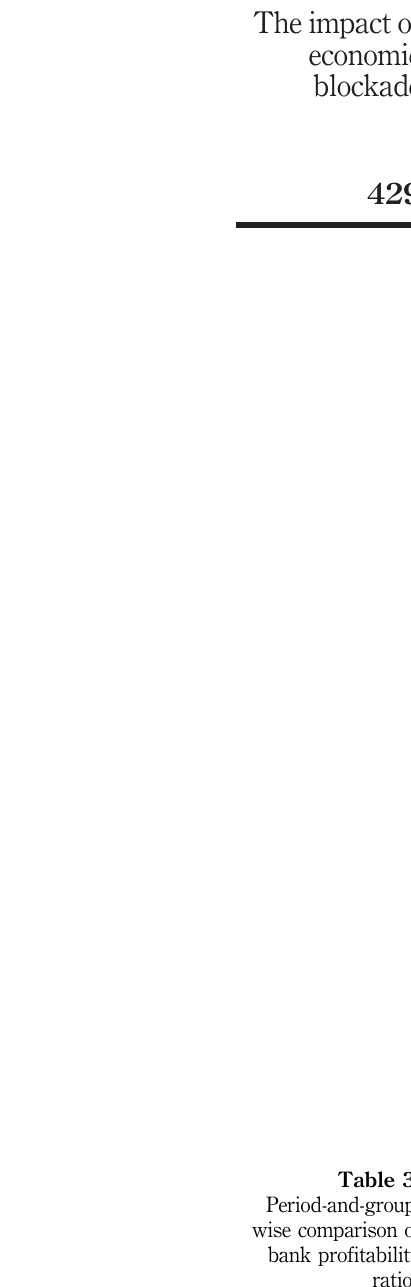
Table 3. Period-and-group- wise comparison of bank profitability